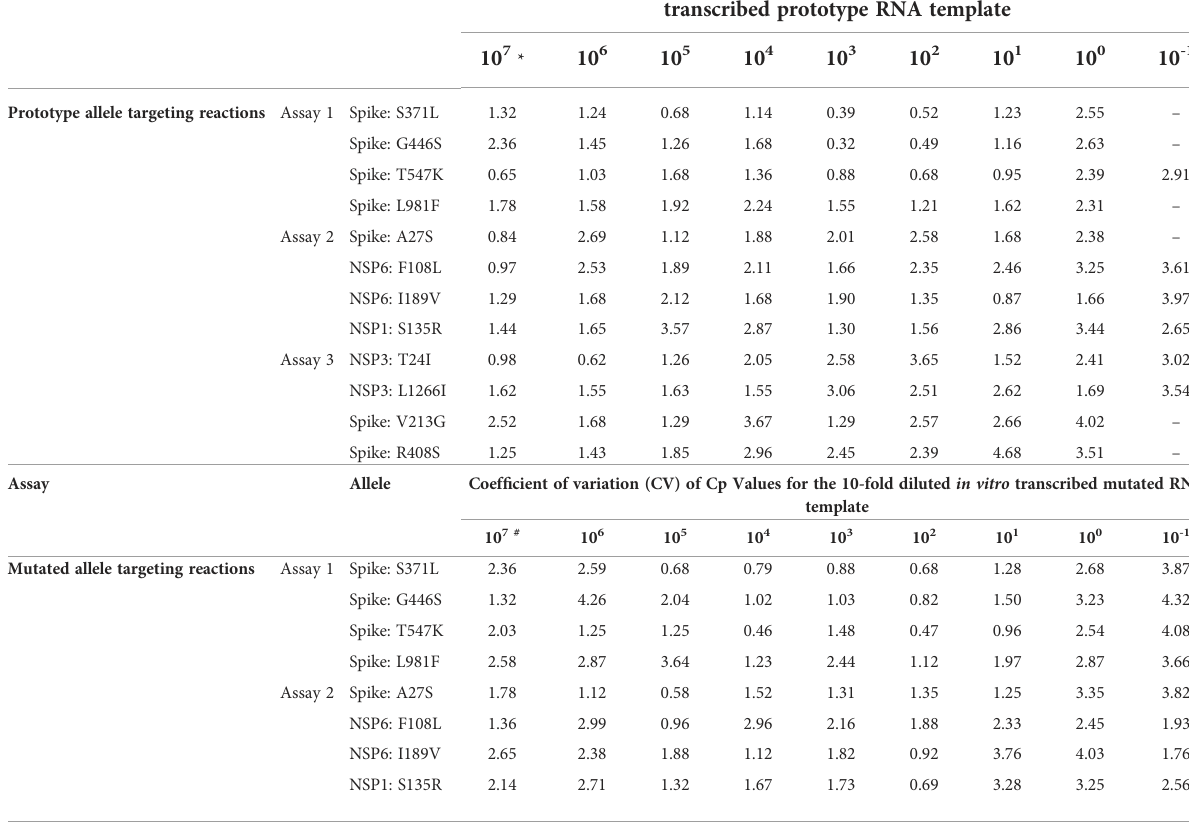
TABLE 4 Inter-assay reproducibility of the developed multiplex allele-speci fi c qRT-PCR assays. Assay Allele Coef fi cient of variation & (CV) of Cp Values for the 10-fold diluted in vitro transcribed prototype RNA template 10 7 *